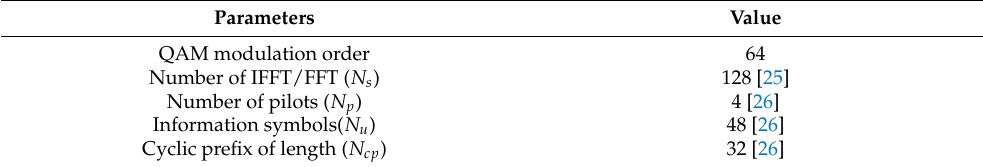
Table 2. The parameters of DCO-OFDM